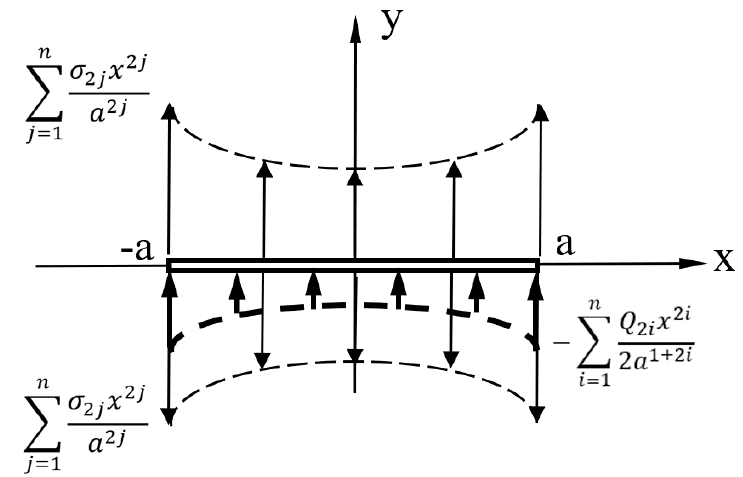
Figure 1. A single crack which is embedded in an orthotropic solid subjected to combined 2 i order polynomial function thermal flux and 2 j order polynomial function mechanical loading.